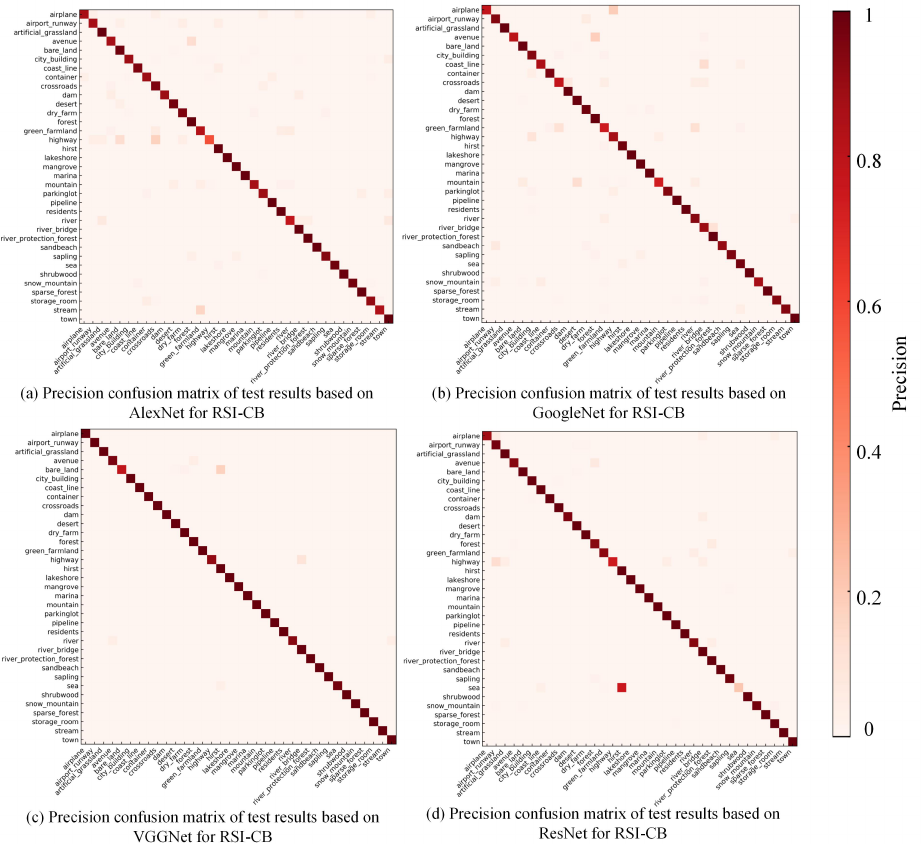
Figure 14. Precision confusion matrix of test results based on DCNN models for